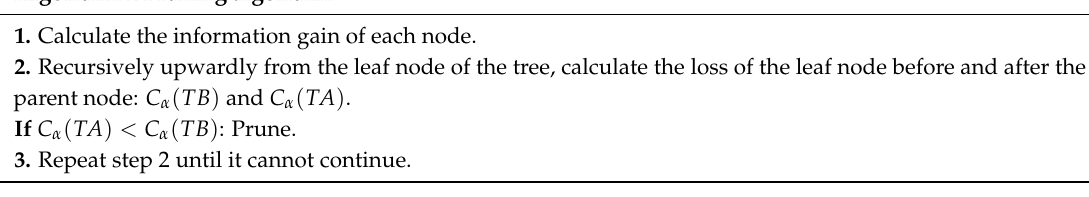
Algorithm 2 Pruning algorithm